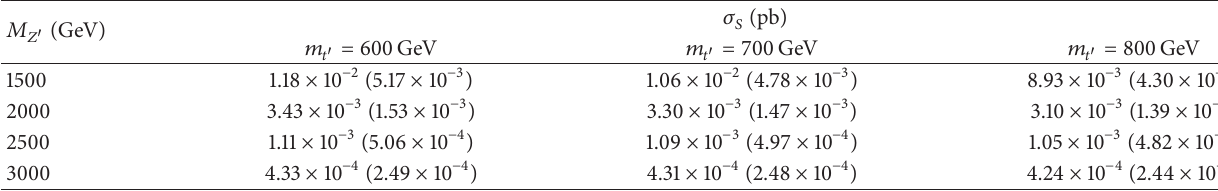
Table 9: The same as Table 7, but for 𝑥 = 0.1 .